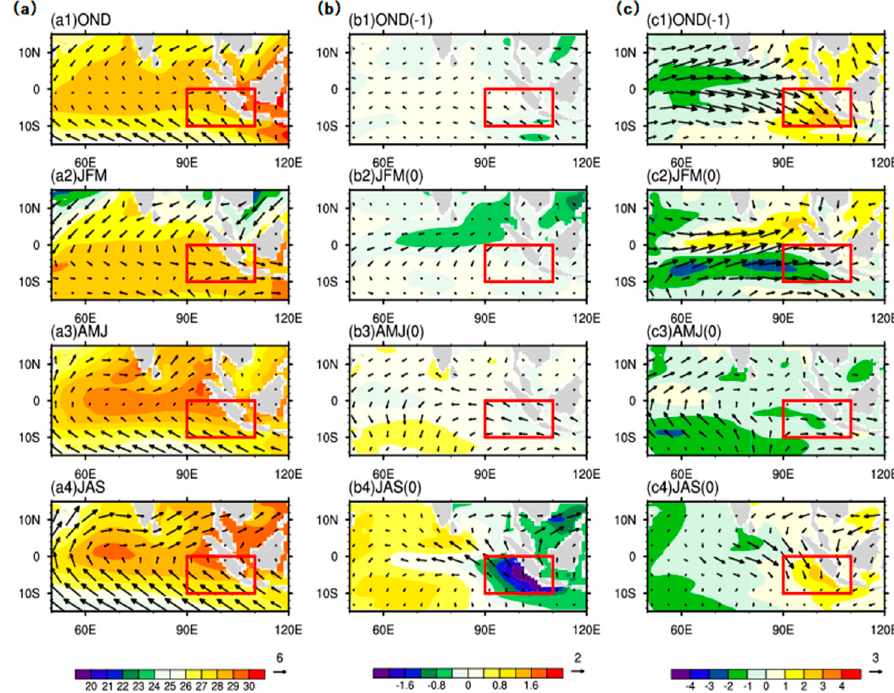
Figure 6. ( a ) Seasonal evolutions for the SST (shaded; units: °C) and surface wind (vectors; units: m/s) of climatological state in Indian Ocean. ( b ) Seasonal evolutions of SSTAs and related wind anomalies of the referenced five pIOD events that occurred with El Niño. ( c ) Seasonal evolutions of SST errors and wind anomalies generated by type-1 initial errors with start month being October (-1). The red rectangle represents the location of the southeastern IO.